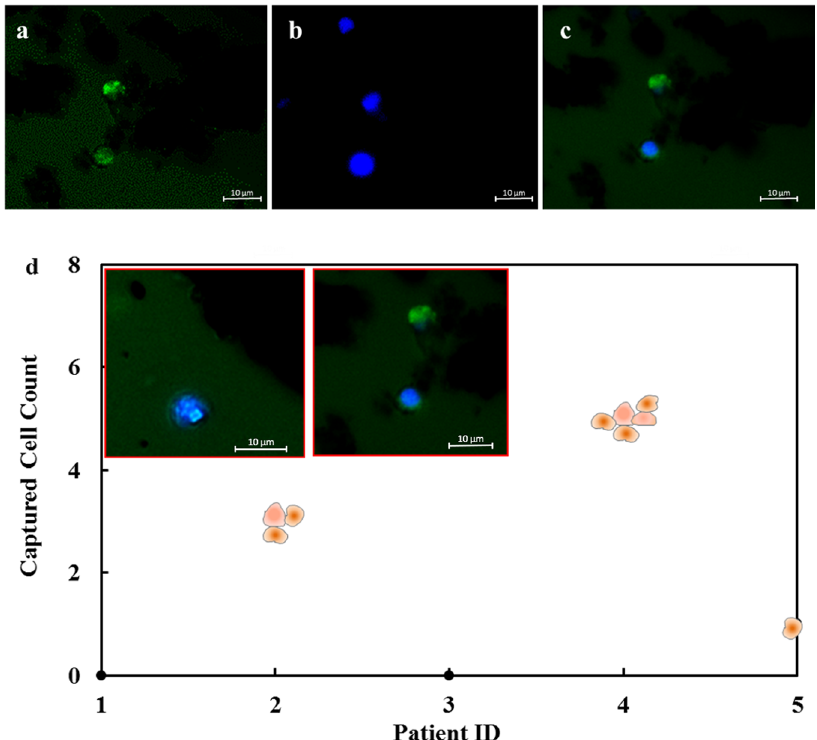
Fig. 6 Fluorescent micrographs of CTCs captured from blood samples from a breast cancer patient. Three-color immunocytochemistry method based on a FITC-labeled anti-Cytokeratin, and b Hoechst nuclear staining. c Composite image from FITC and Hoechst micrographs. d Plot of CTCs captured by MFN in 1 mL peripheral blood samples from epithelial cancer